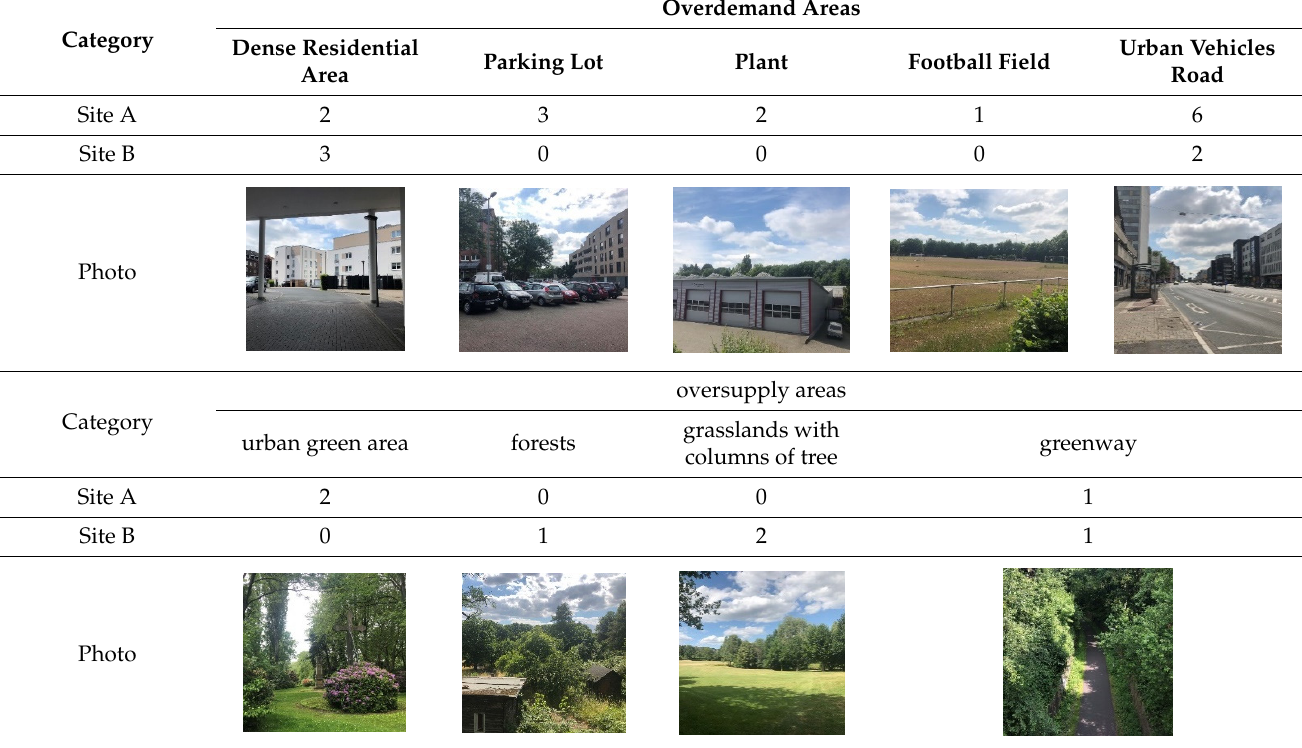
Table 3. Statistical table of different overdemand and oversupply areas in both downscaling sites.